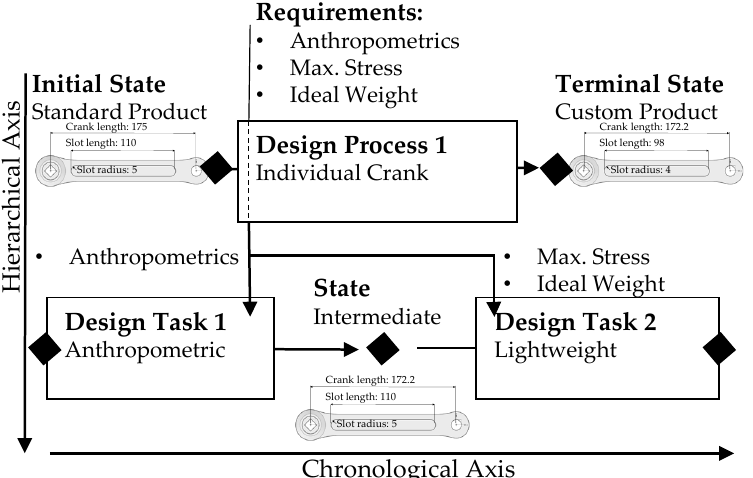
Figure 8. Illustration of a MC process model for an individual bike crank, changing from a standard crank to a custom crank through two Design